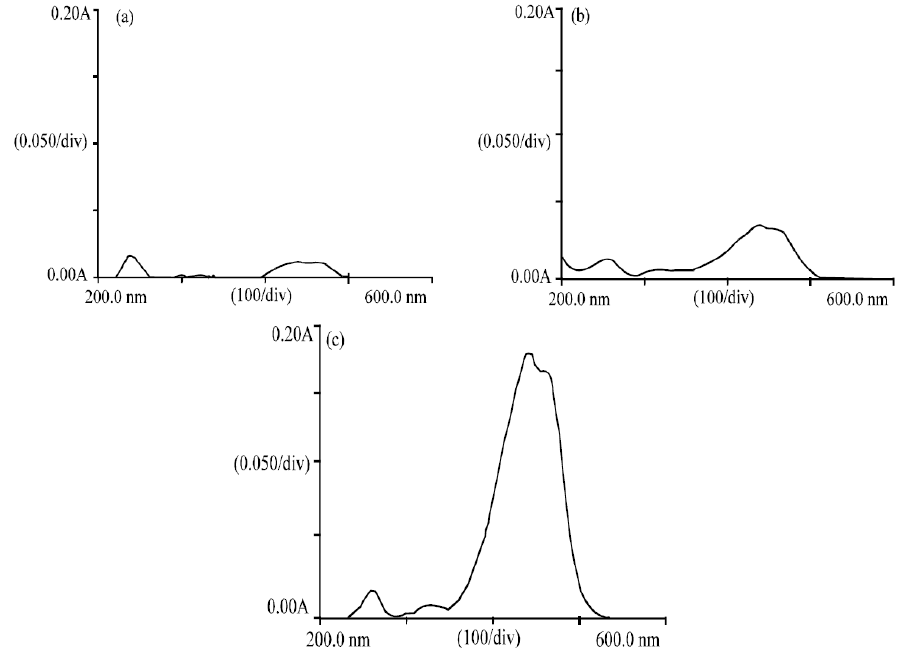
Figure 7. Spectrophotometry of samples in water (2 μgmL -1 ), (a) Fluka crocin, (b) saffron stigma extract sample and (c) crystallized